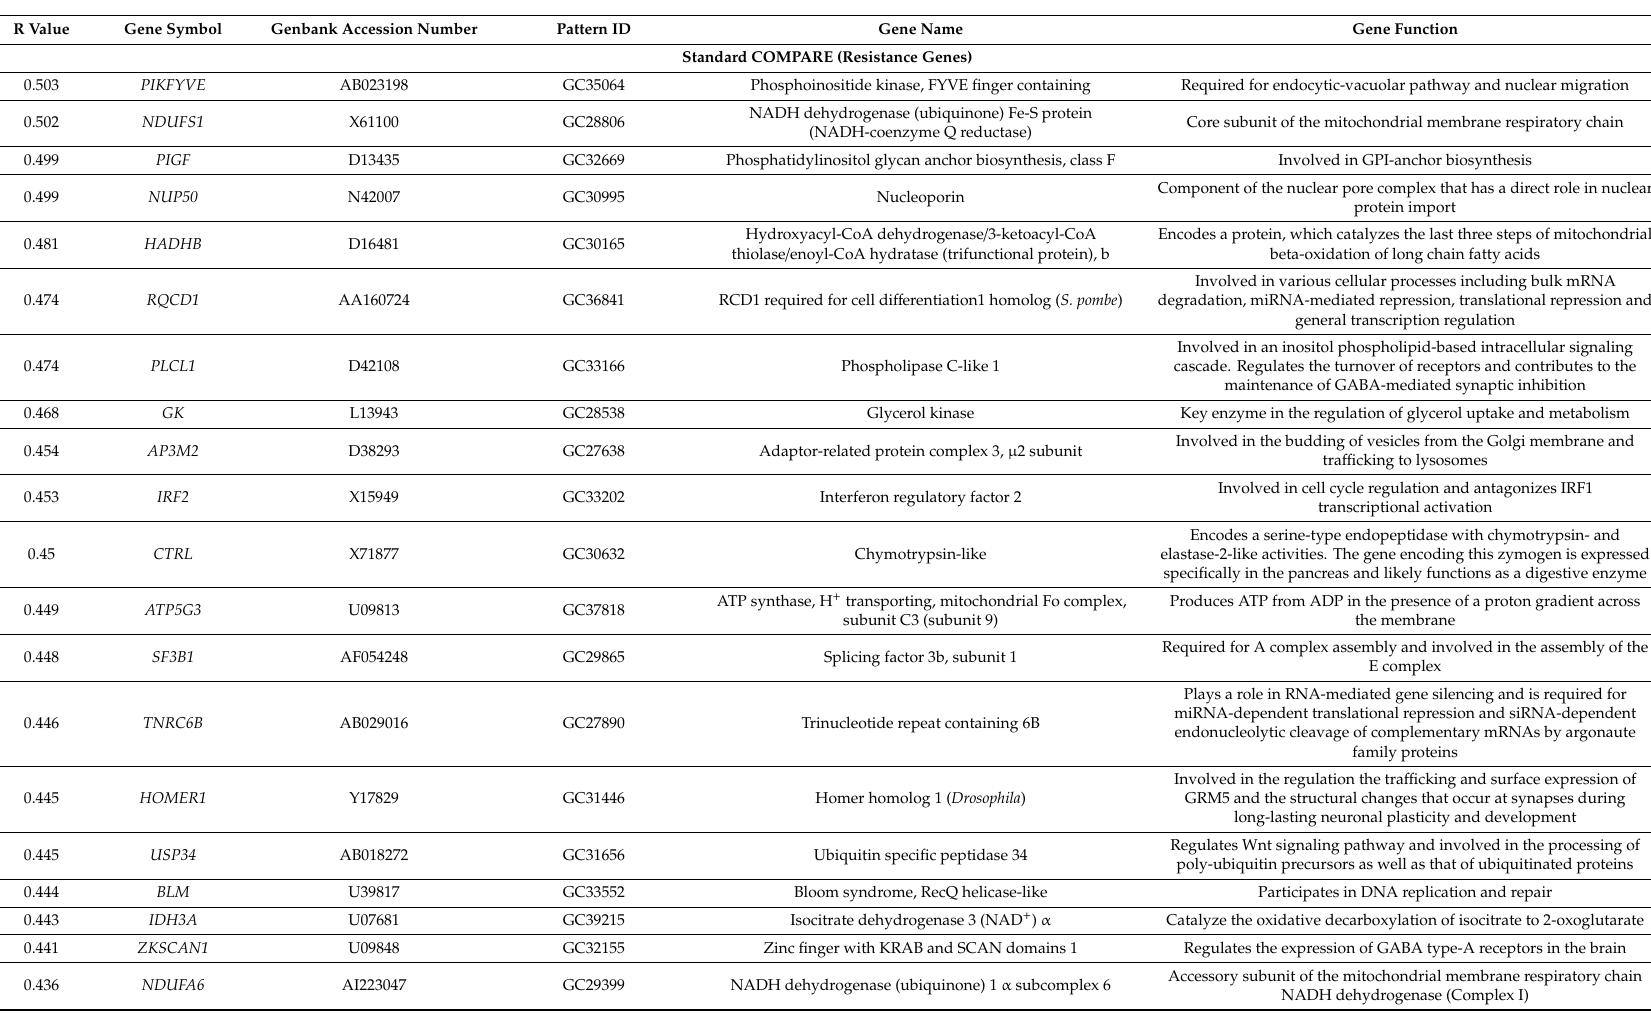
Table 1. COMPARE analysis of genes, whose microarray-based mRNA expression correlated with log 10 IC 50 values for secalonic acid in a panel of 59 cell lines. R